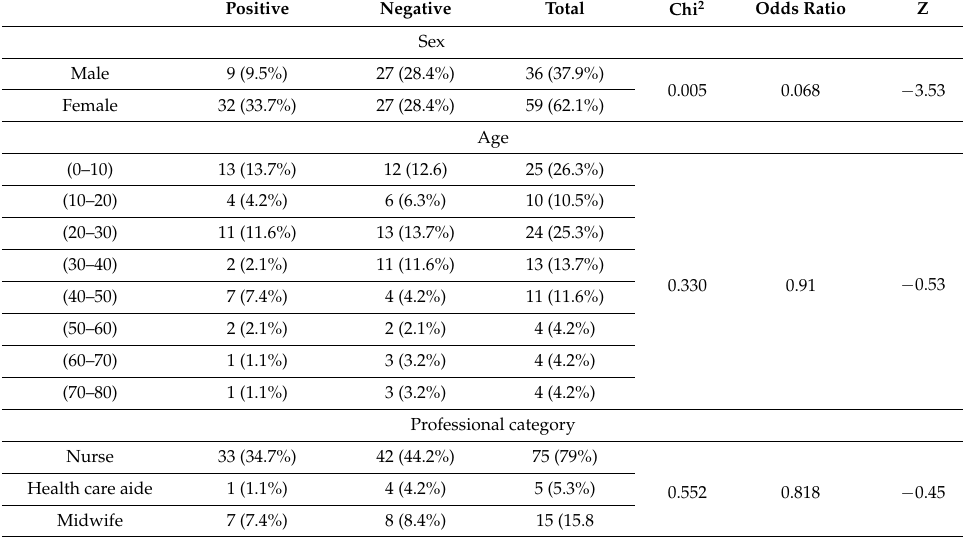
Table 2. Sociodemographic data and some data related to catheterization in the departmental Hospital of Lokossa and the Com è ’s Area